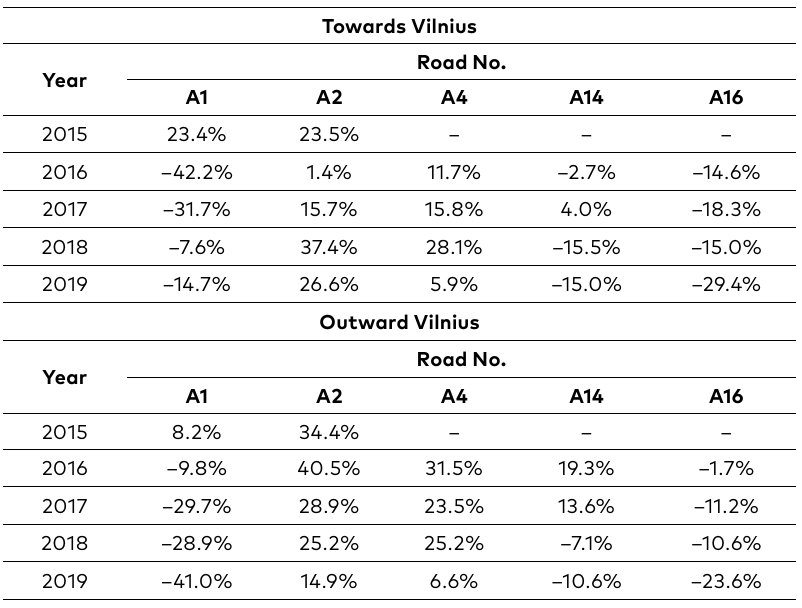
Table 6. Differences between traffic volume towards and outward Vilnius during “All Saints Day” and a regular